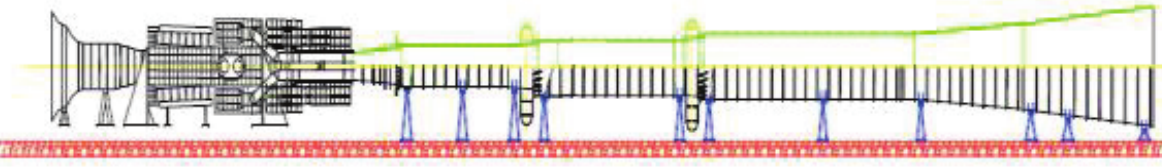
Figure 1. Schematic of wind tunnel.